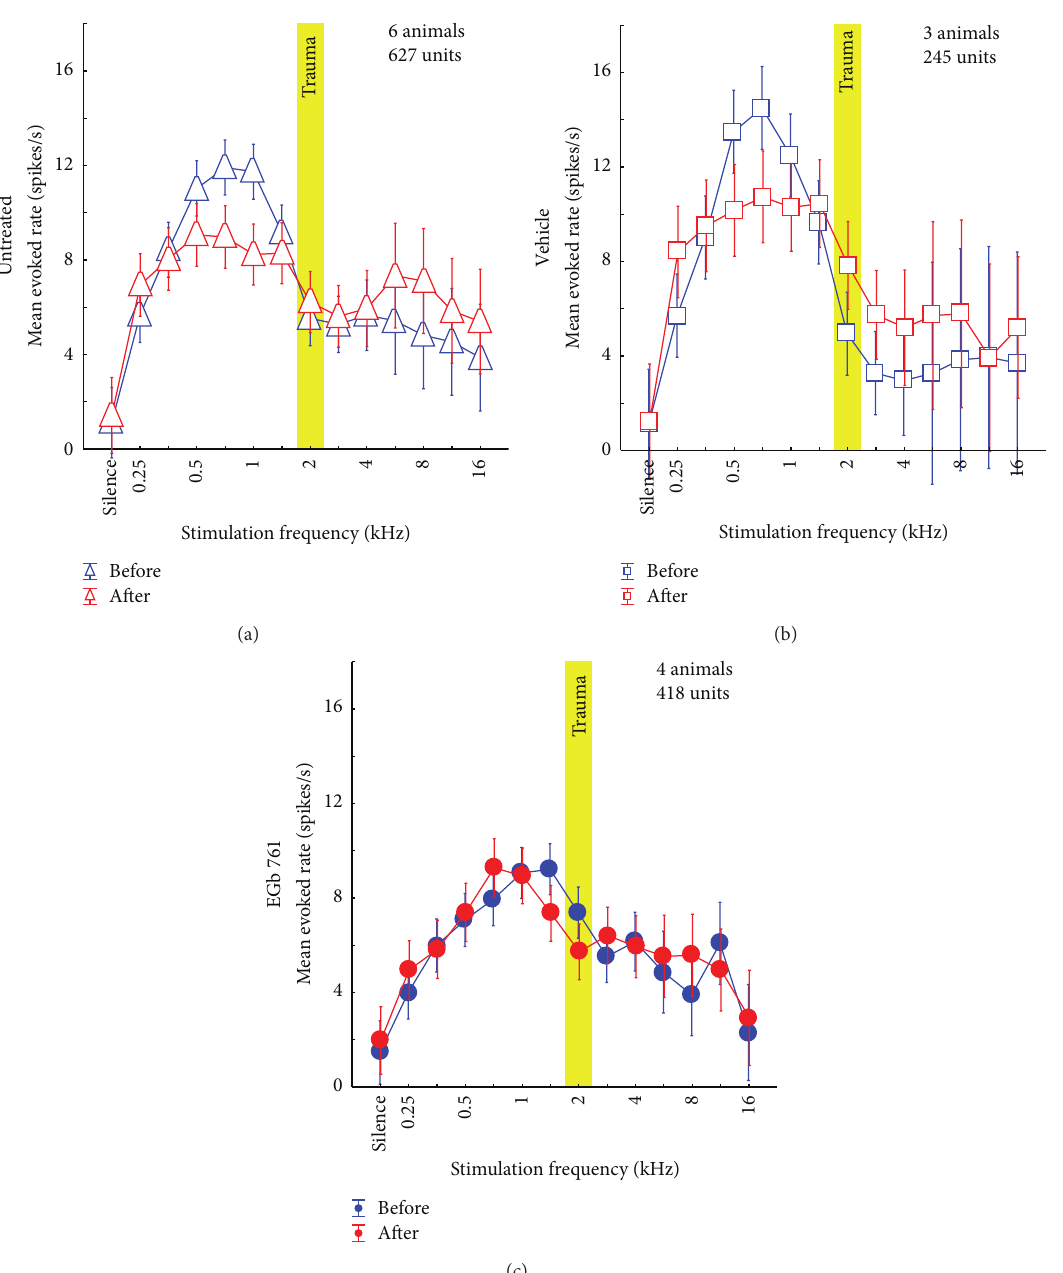
Figure 6: Mean evoked neuronal response ( ± 95% confidence interval) to iso-intensity pure tone stimulation across all recorded units in (a) untreated animals from an earlier study [31], (b) vehicle treated animals, and (c) EGb 761-treated animals. Depicted are the mean evoked rates (spikes/s) before (blue) and after (red) acoustic trauma at 2 kHz (yellow bar). For statistical values please refer to Section